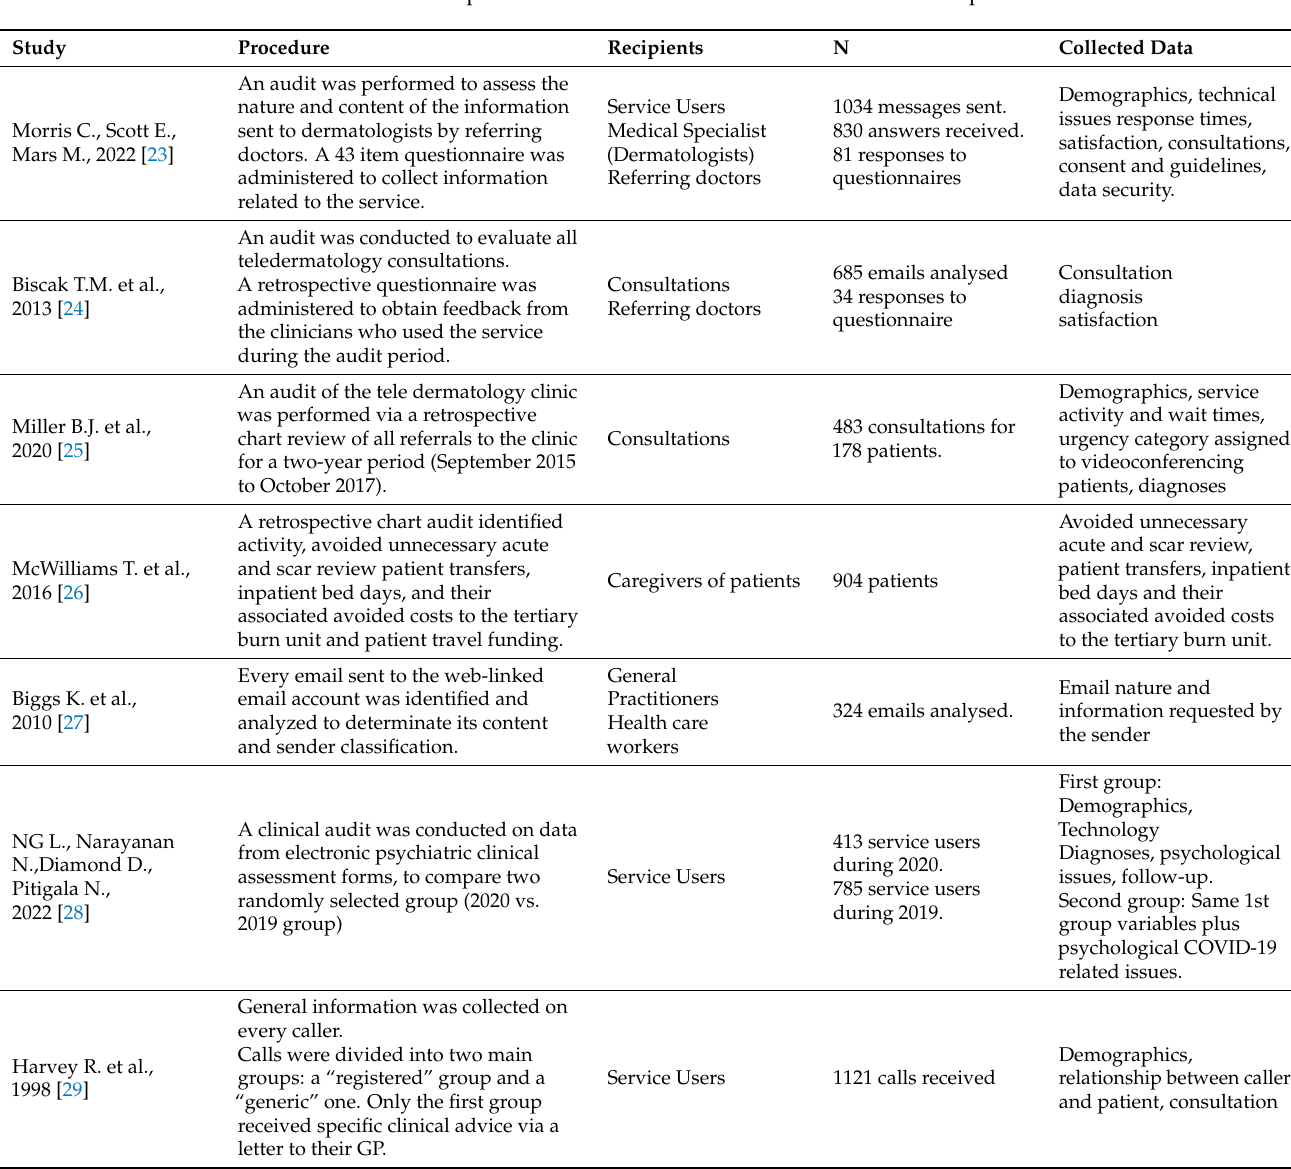
Table 3. Description of the audit features included within the studies performed on telemedicine